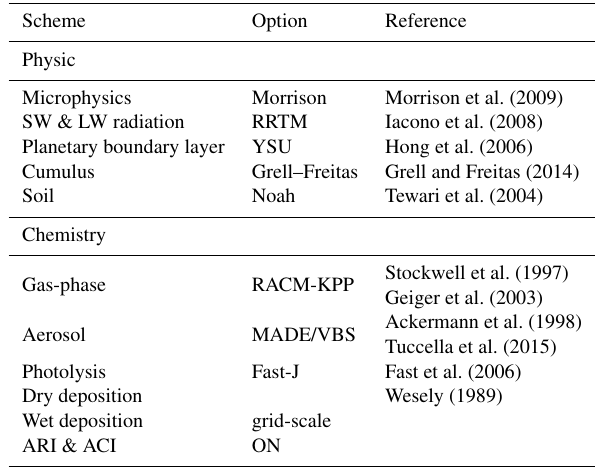
Table 1. WRF-Chem physical and chemical configuration used in the sensitivity